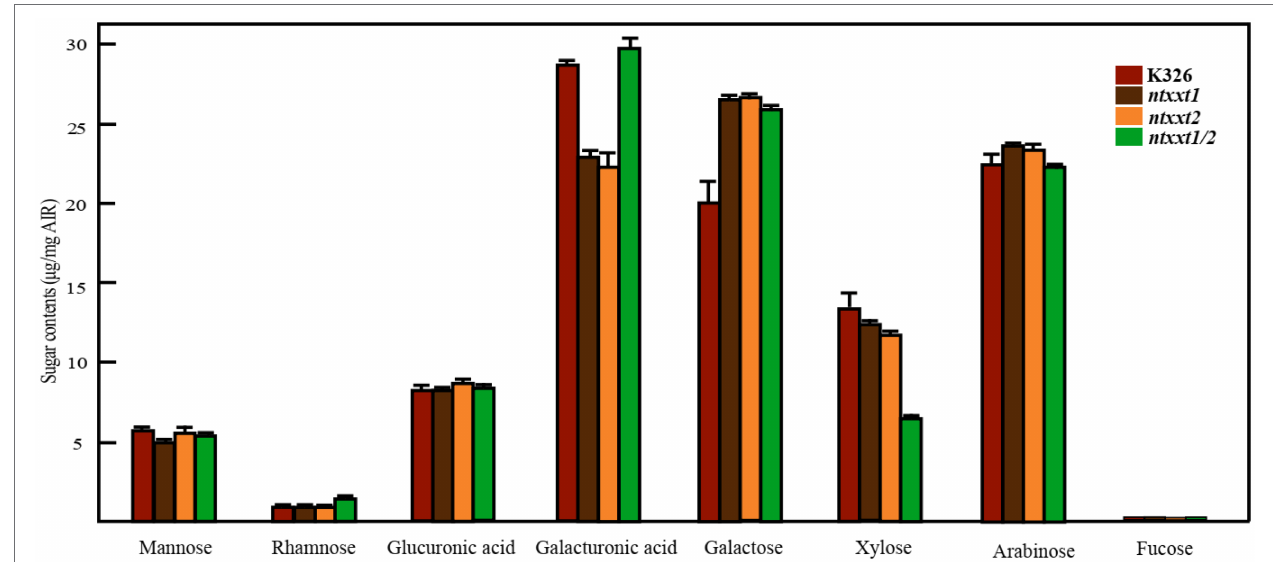
FIGURE 5 | The glycosyl residue compositions of the AIR from K326, ntxxt1 , ntxxt2 , and ntxxt1/2 leaves. These experiments were performed in triplicate. Error bars, mean ± SE.